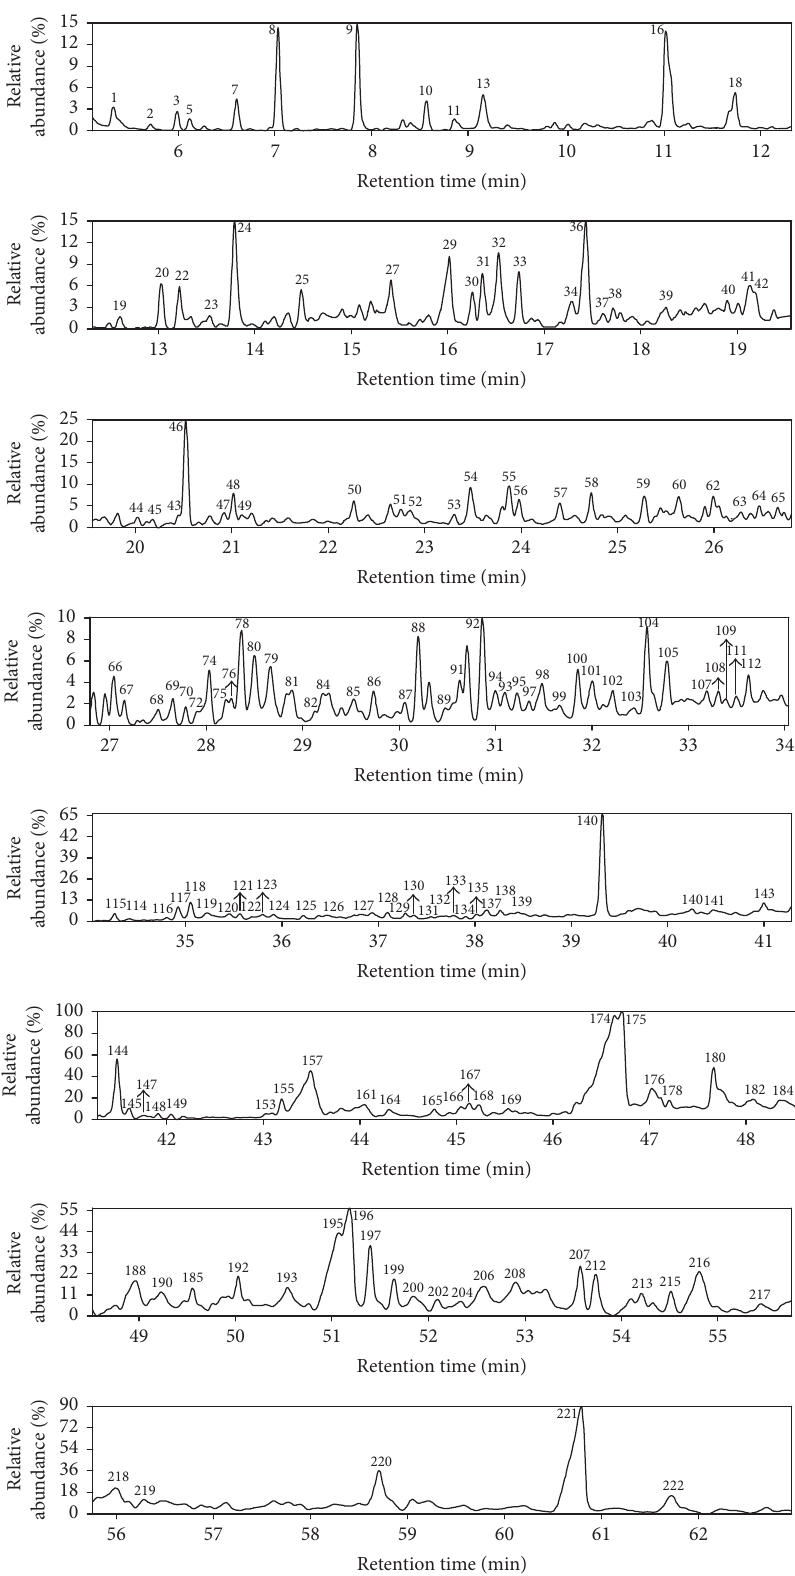
Figure 3: Total ion chromatogram of the reaction product from CHC of